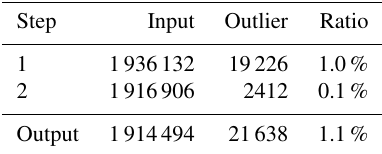
Table 3. Outliers detection in 2